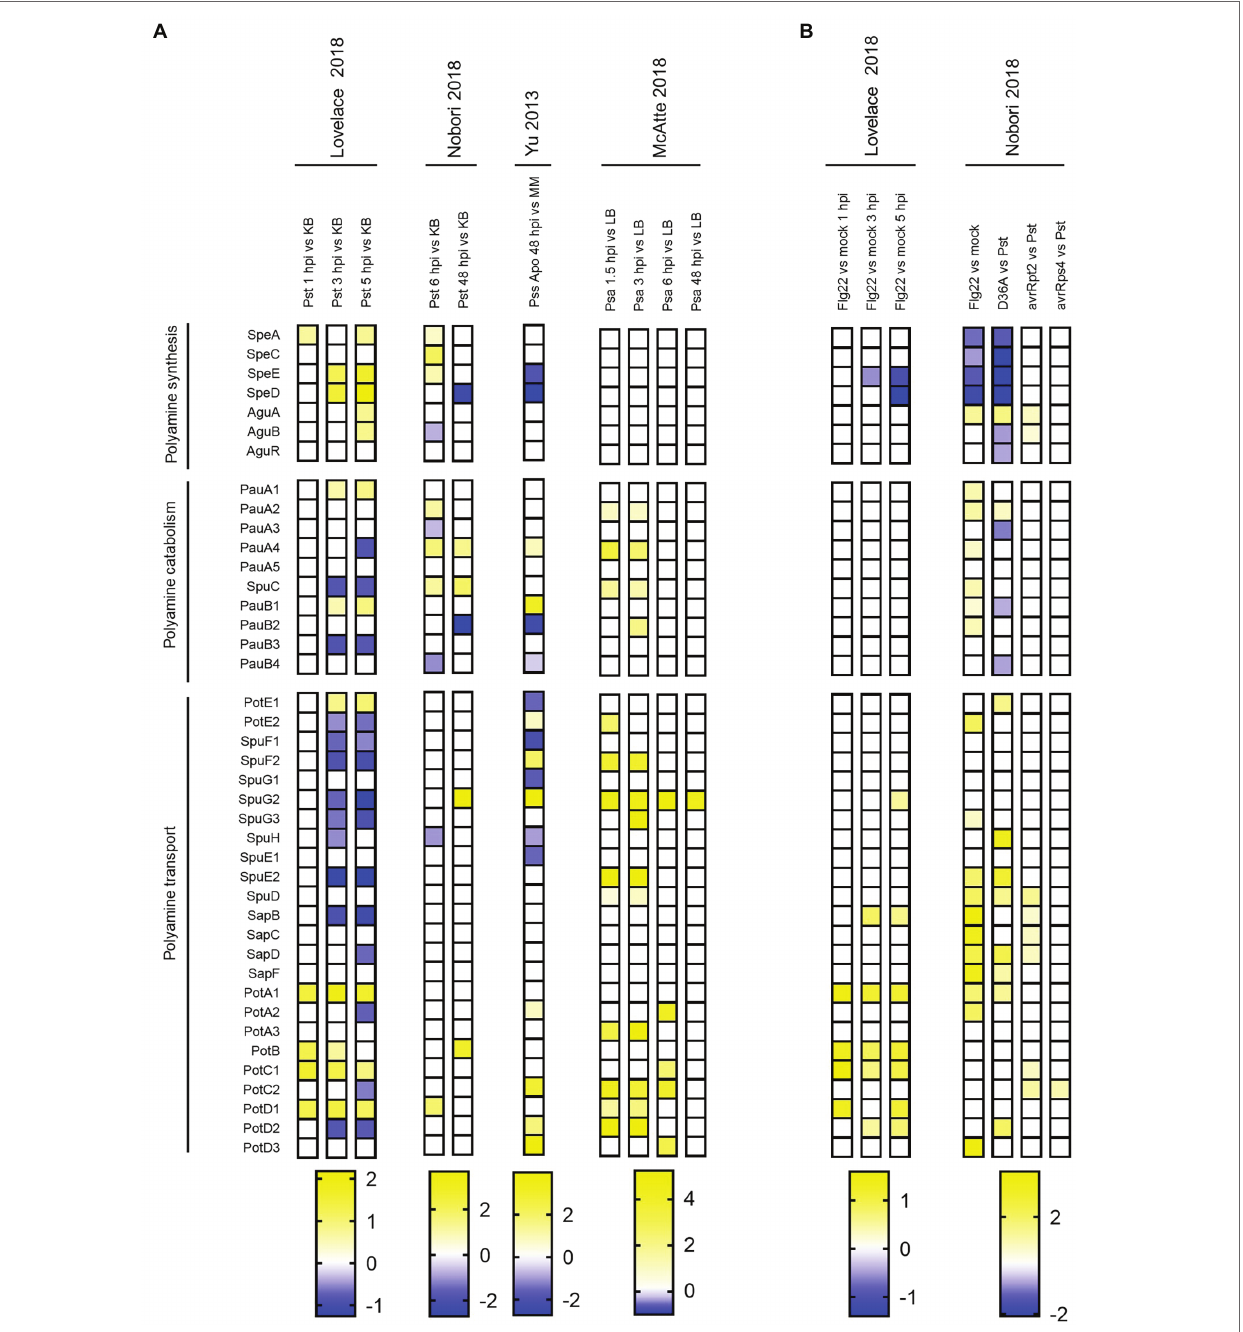
FIGURE 3 | Polyamine metabolism gene expression in P. syringae during growth in plant tissues. Heatmap illustrating polyamine metabolism gene expression levels in P. syringae during (A) plant invasion (apoplastic growth) in comparison to basal conditions and (B) in flg22-treated plants compared to mock-inoculated plants (Flg22 vs. mock), and in non-virulent strains compared to WT Pst (D36A vs. Pst, avrRpt2 vs. Pst and avrRps4 vs. Pst). Color scales represent expression levels reported by the authors of indicated references, and they were considered if log 2 FC > |0.5| and p adj <